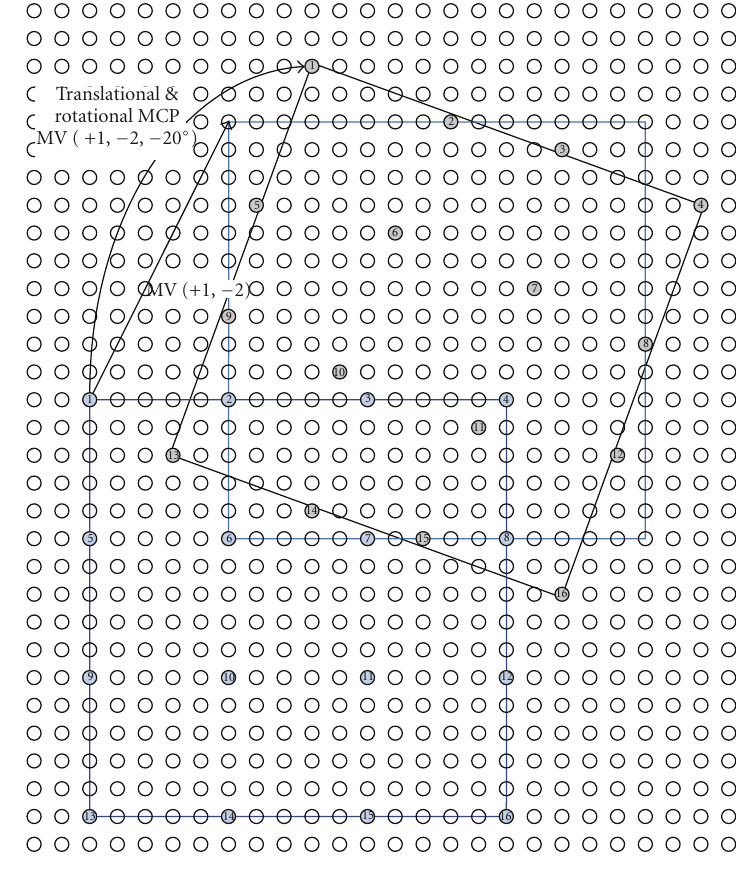
Step 2. At the position pointed by the best translational